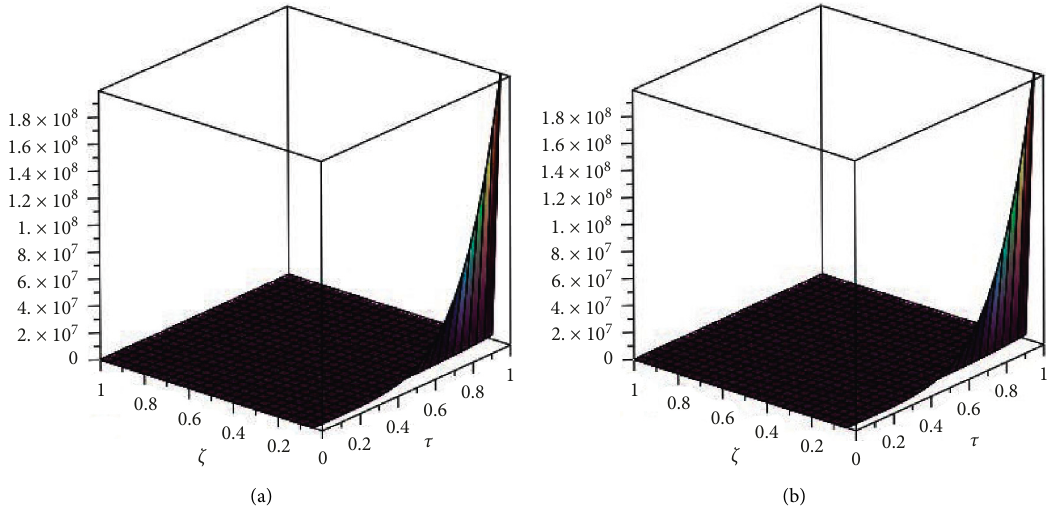
Figure 1: Graph of (a) exact and (b) analytic solutions of β � 1 of Example 1.